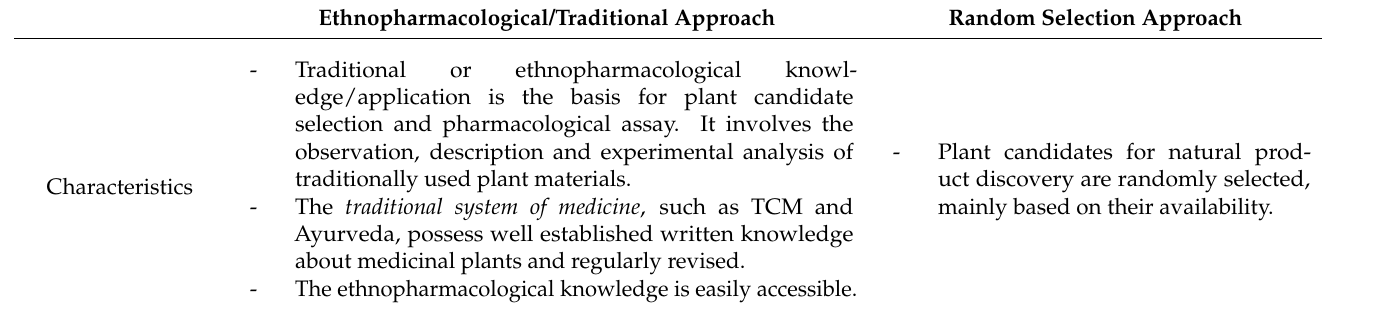
Table 2. Ethnopharmacological/traditional approach versus random screening approach of plant